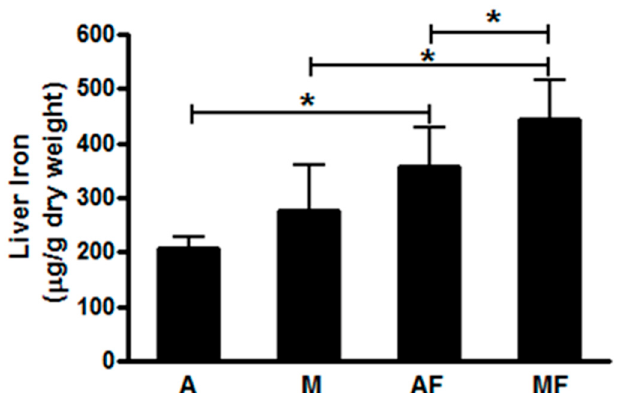
Figure 4. Effect of fructose feeding on liver iron in male weanling Sprague-Dawley rats. Data represent means ± SD ( n = 5–10) and analyzed by two-way ANOVA, * p < 0.05; A, adequate copper diet; M, marginal copper deficient diet; AF, adequate copper diet + 3% fructose drinking; MF, marginal copper deficient diet + 3% fructose drinking.